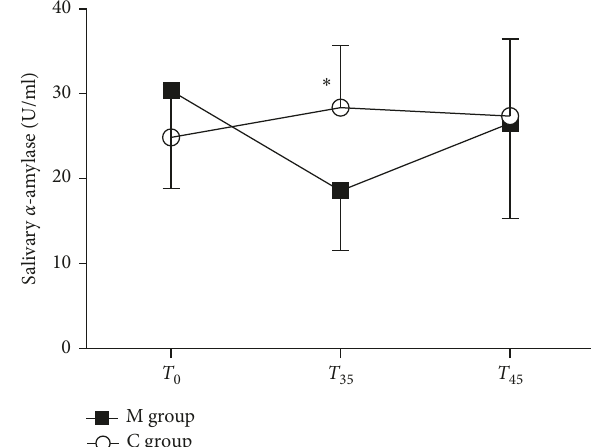
Figure 4: Salivary α -amylase levels (U/ml). Salivary α -amylase levels (U/ml) in the music group (M group) and control group (C group) at T 0 , T 35 , and T 45 . Data are presented as mean